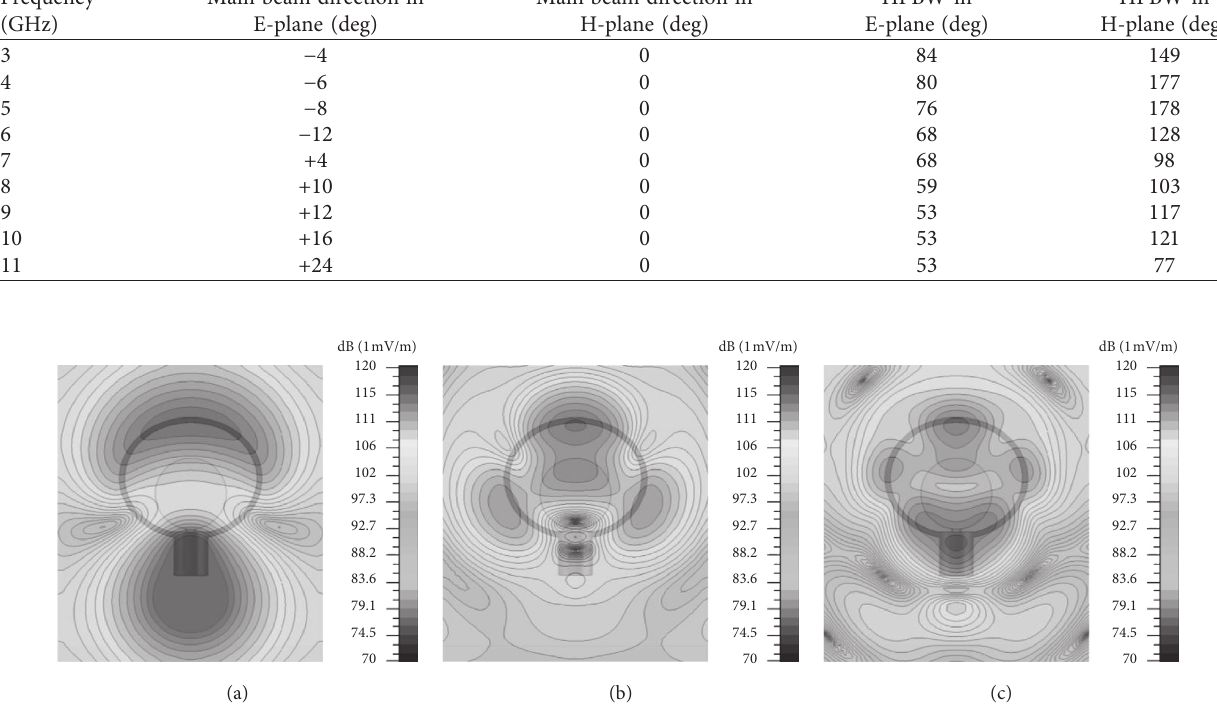
Figure 14: Electric fields near the antenna aperture. (a) 3.1GHz. (b) 6.8GHz. (c)